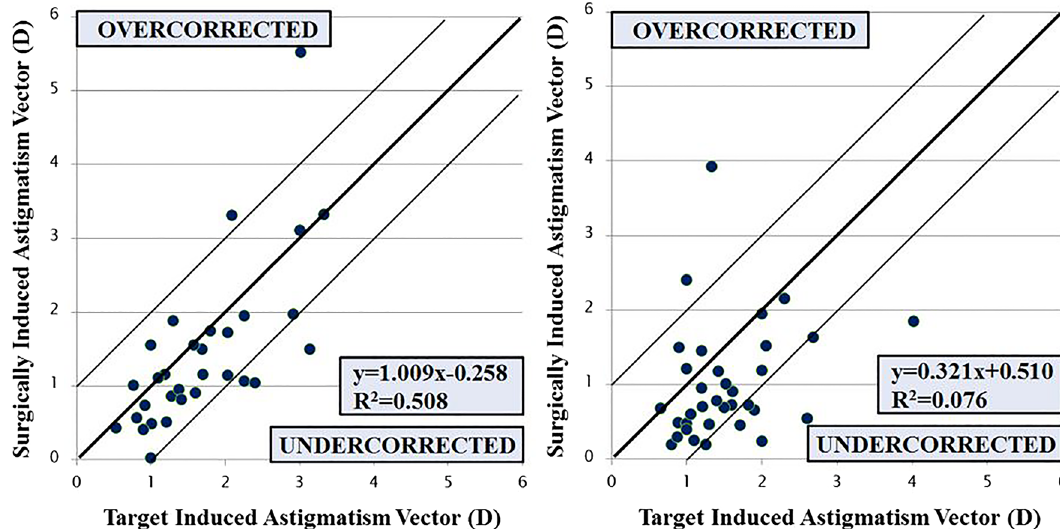
Figure 3. TIA versus SIA plots (refractive astigmatism) of patients treated with toric IOL implantation ( left ) and femtosecond laser-assisted astigmatic keratotomy ( right ). The thin lines represent the range within ± 1.0 D, respectively, between 2 parameters. The rate of strong overcorrection (above the superior thin line) and undercorrection (below the inferior thin line) was not statistically different between the two groups ( TIA target- induced astigmatism; SIA surgically induced